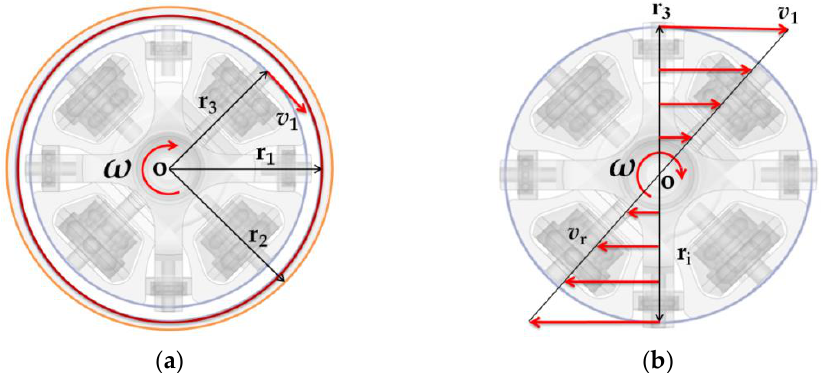
Figure 6. The velocities of the inner cylinder: ( a ) on the side surface; ( b ) on the bottom surface. A traditional relation N u = 0.023 R e 0.8 P r 0.3 , recommended by Dittus and Boelter